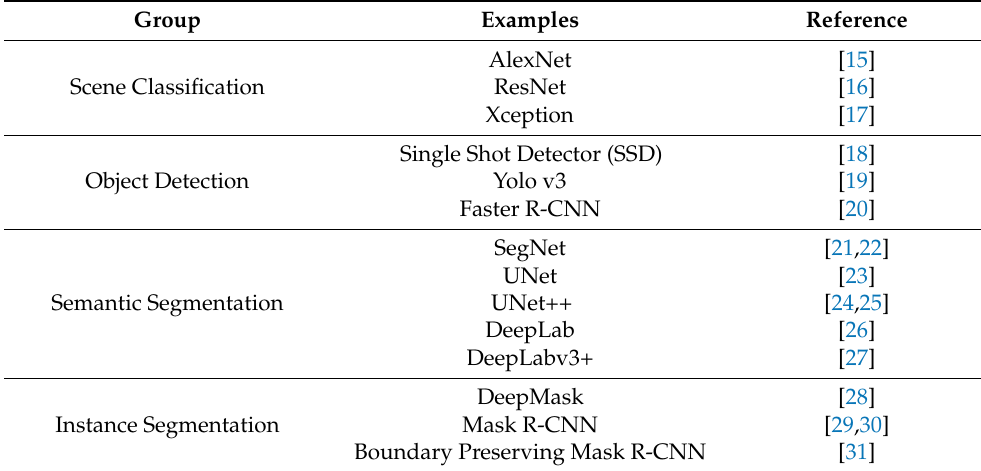
Figure 1. Example of different CNN-based mapping problem types. Example data are from the LandCover.ai dataset [14]. ( a ) scene classification, ( b ) object detection, ( c ) semantic segmentation and ( d ) instance segmentation. Table 1. Example DL architectures for the four different types of mapping problems with associ- ated